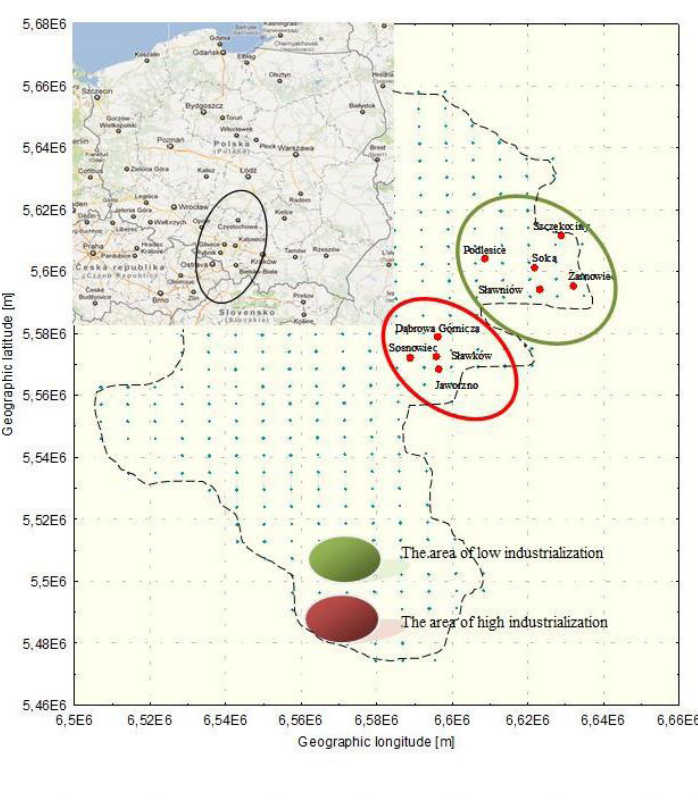
Figure 5. Map of the Voivodeship of Silesia, along with sampling points.